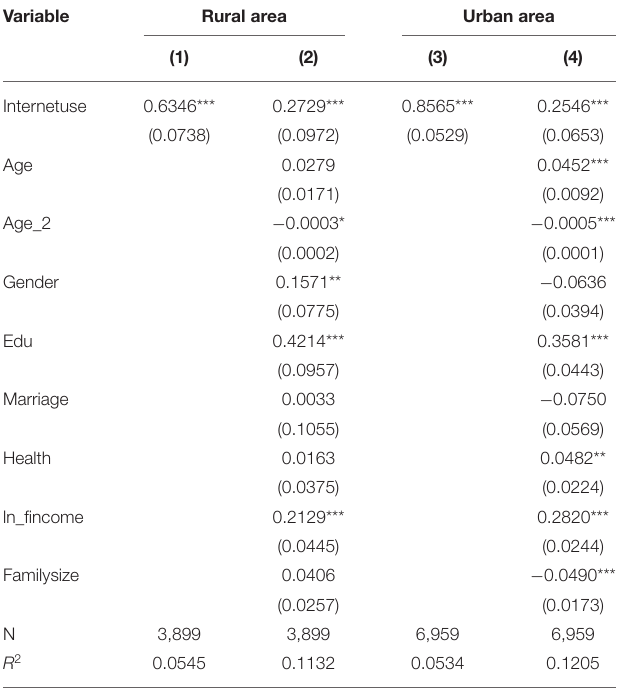
TABLE 5 | Heterogeneity test-Urban-rural differences.